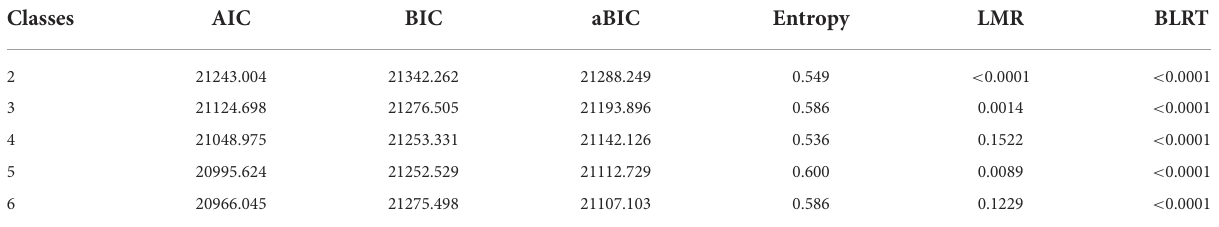
TABLE 1 LCA model fit statistics ( N = 2,537).